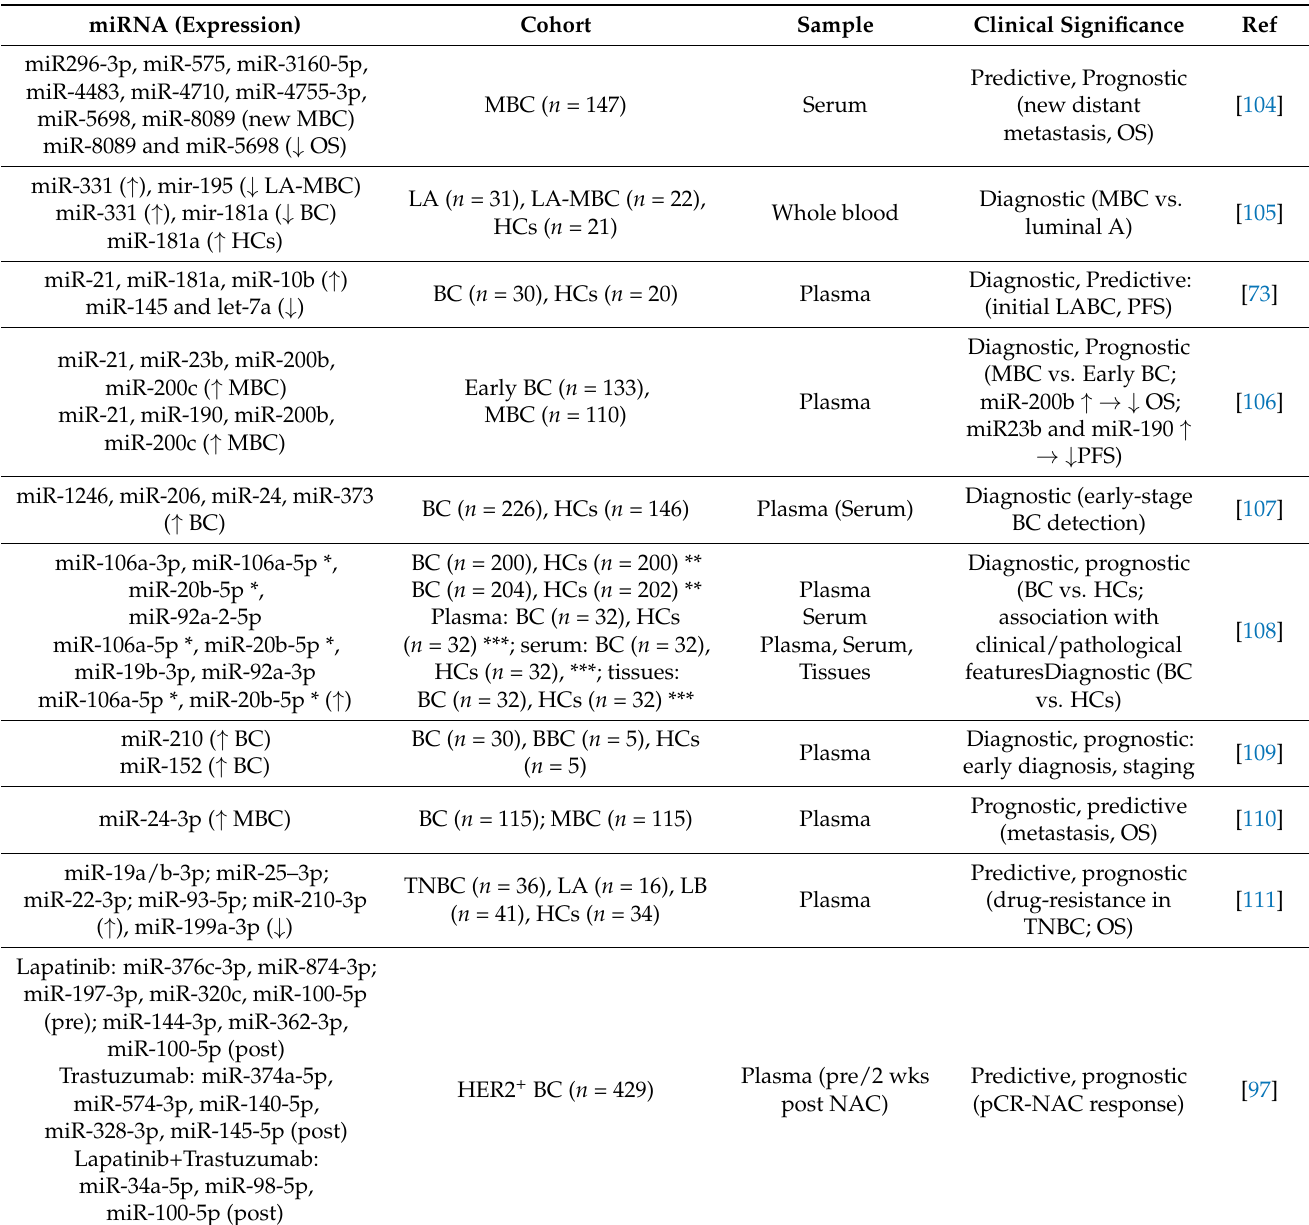
Table 1. Circulating miRNA as potential diagnostic, predictive and prognostic